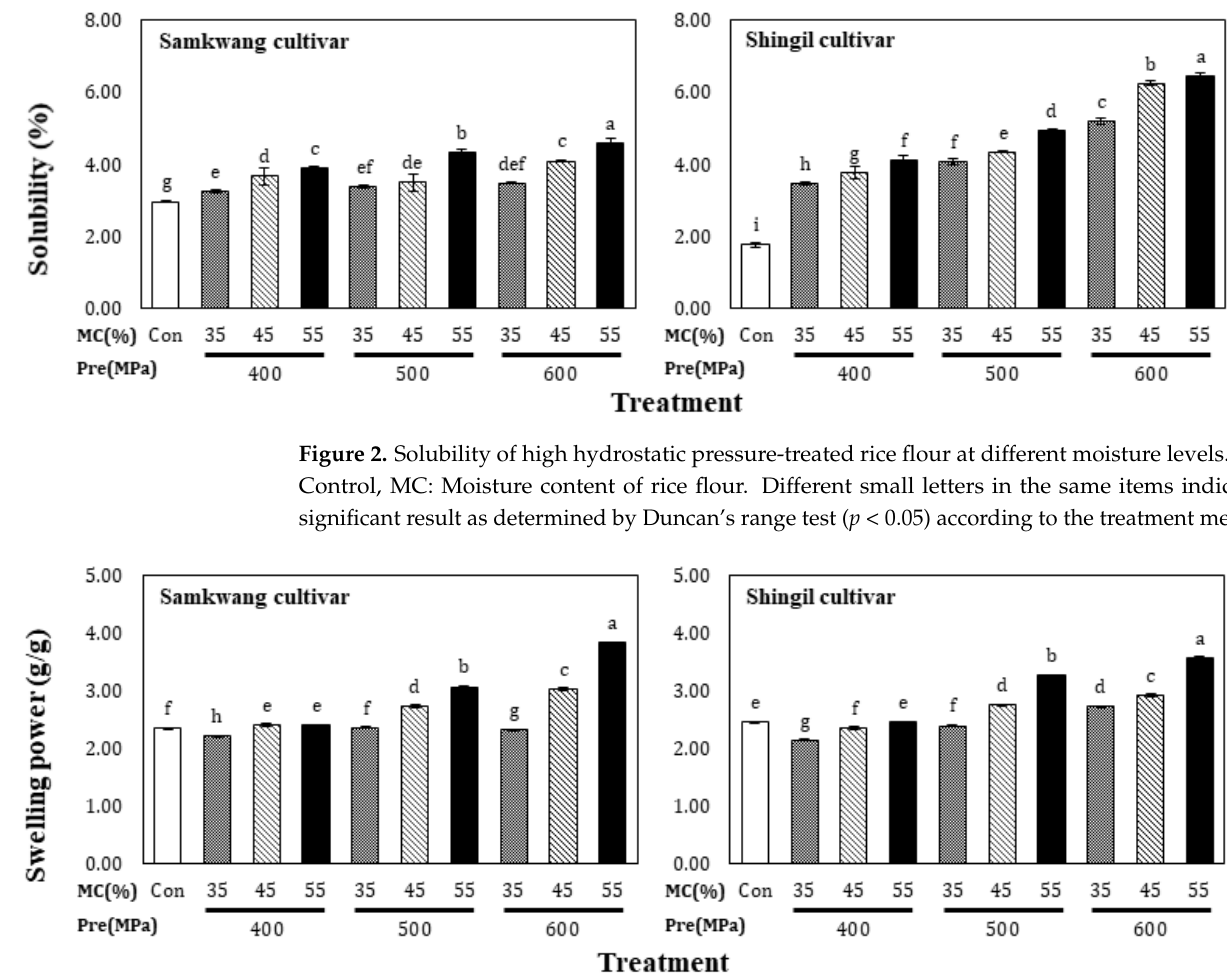
Figure 3. Swelling power of high hydrostatic pressure-treated rice flour at different moisture levels. Con: Control, MC: Moisture content of rice flour. Different small letters in the same items indicate a significant result as determined by Duncan’s range test ( p < 0.05), according to the treatment